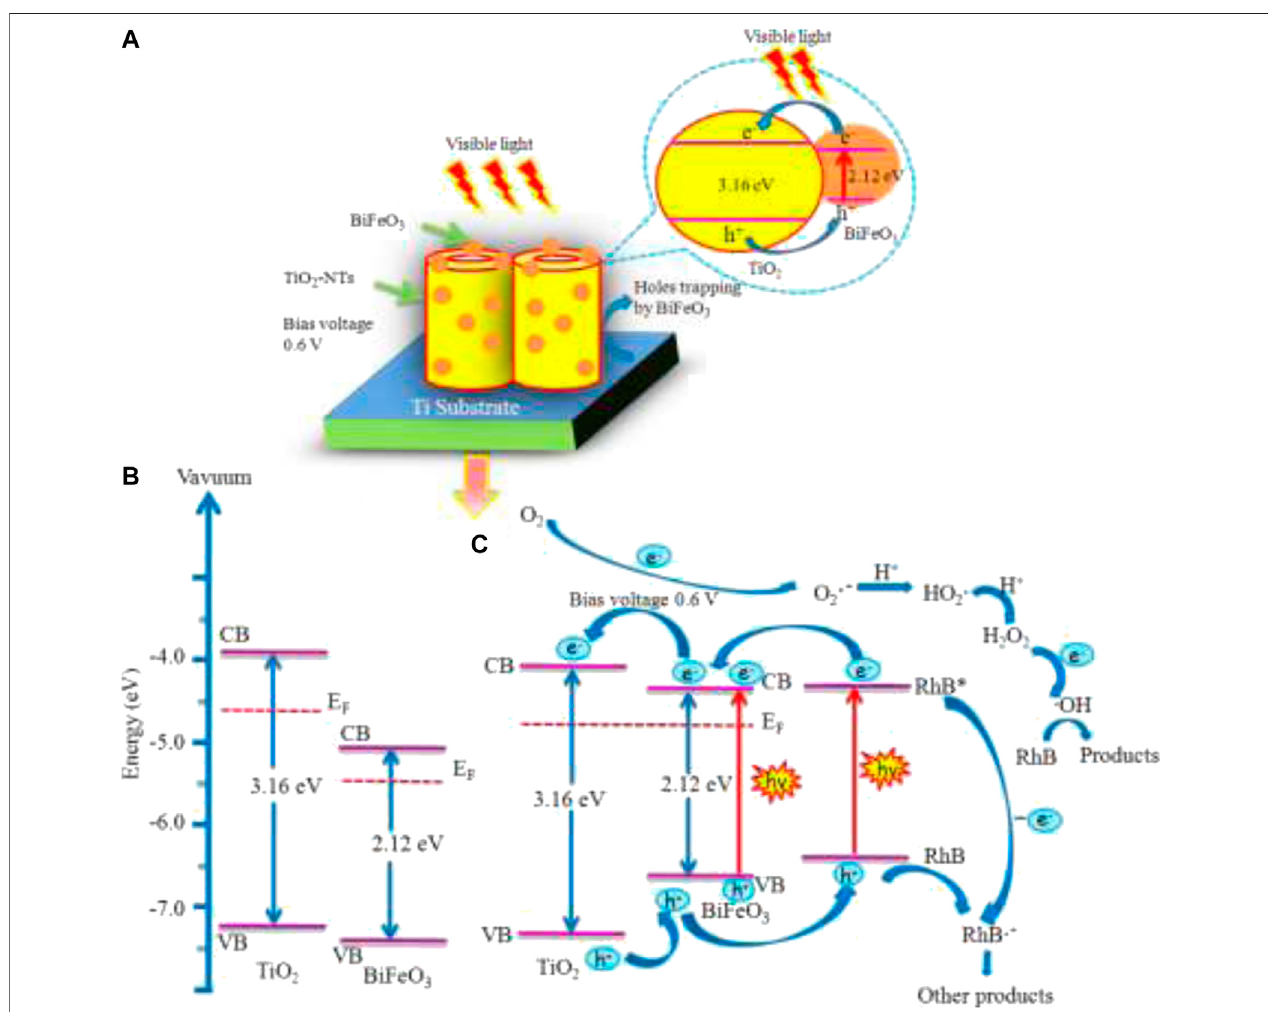
FIGURE 6 | (A) Cartoon diagram of the photogenerated electron generation, separation, and transfer path in BiFeO 3 /TiO 2 -NTs upon visible-light excitation. (B) Conduction band, valence band, and Fermi-level positions of independent n-type TiO 2 and n-type BiFeO 3 . (C) Schematic pathways of PEC degradation of RhB over BiFeO 3 /TiO 2 -NTs under a bias of 0.6 V applied onto the composite electrode (Zhu A. et al., 2014).